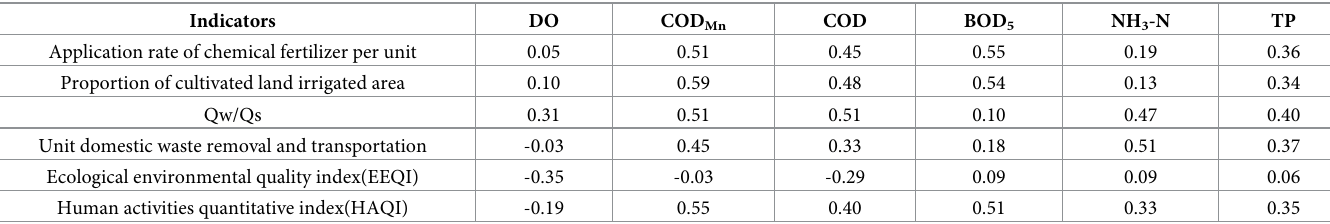
Table 8. Analysis results of the relationships between the main elements exceeding standard limits and their influencing